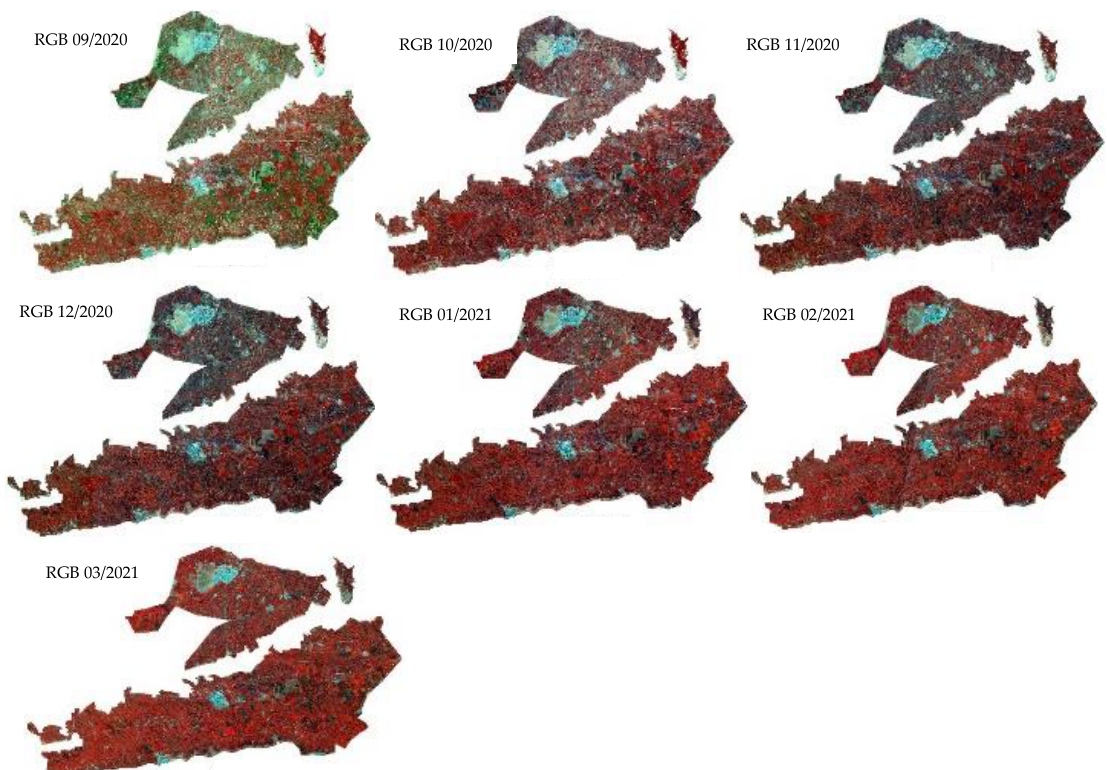
Figure 5. Sentinel-2 RGB monthly images (False Color Combination: NIR, Red, Green band as RGB) from September 2020 to March 2021 of the Tadla Irrigated Perimeter (TIP).